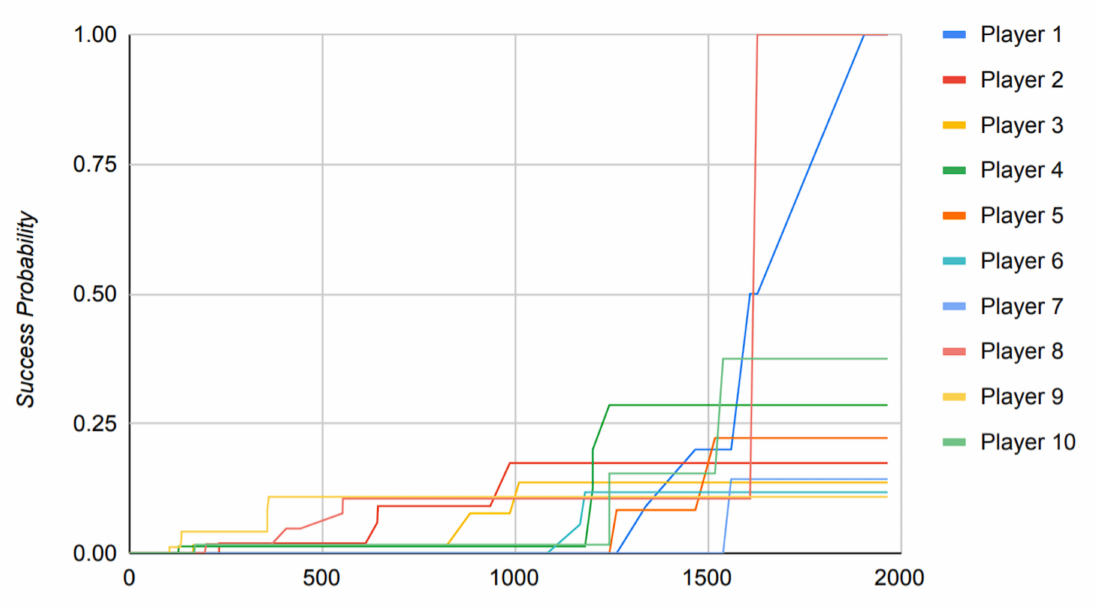
Figure 16. Success probabilities of top ~11% of players from a set of 91 players from a match of PUBG.